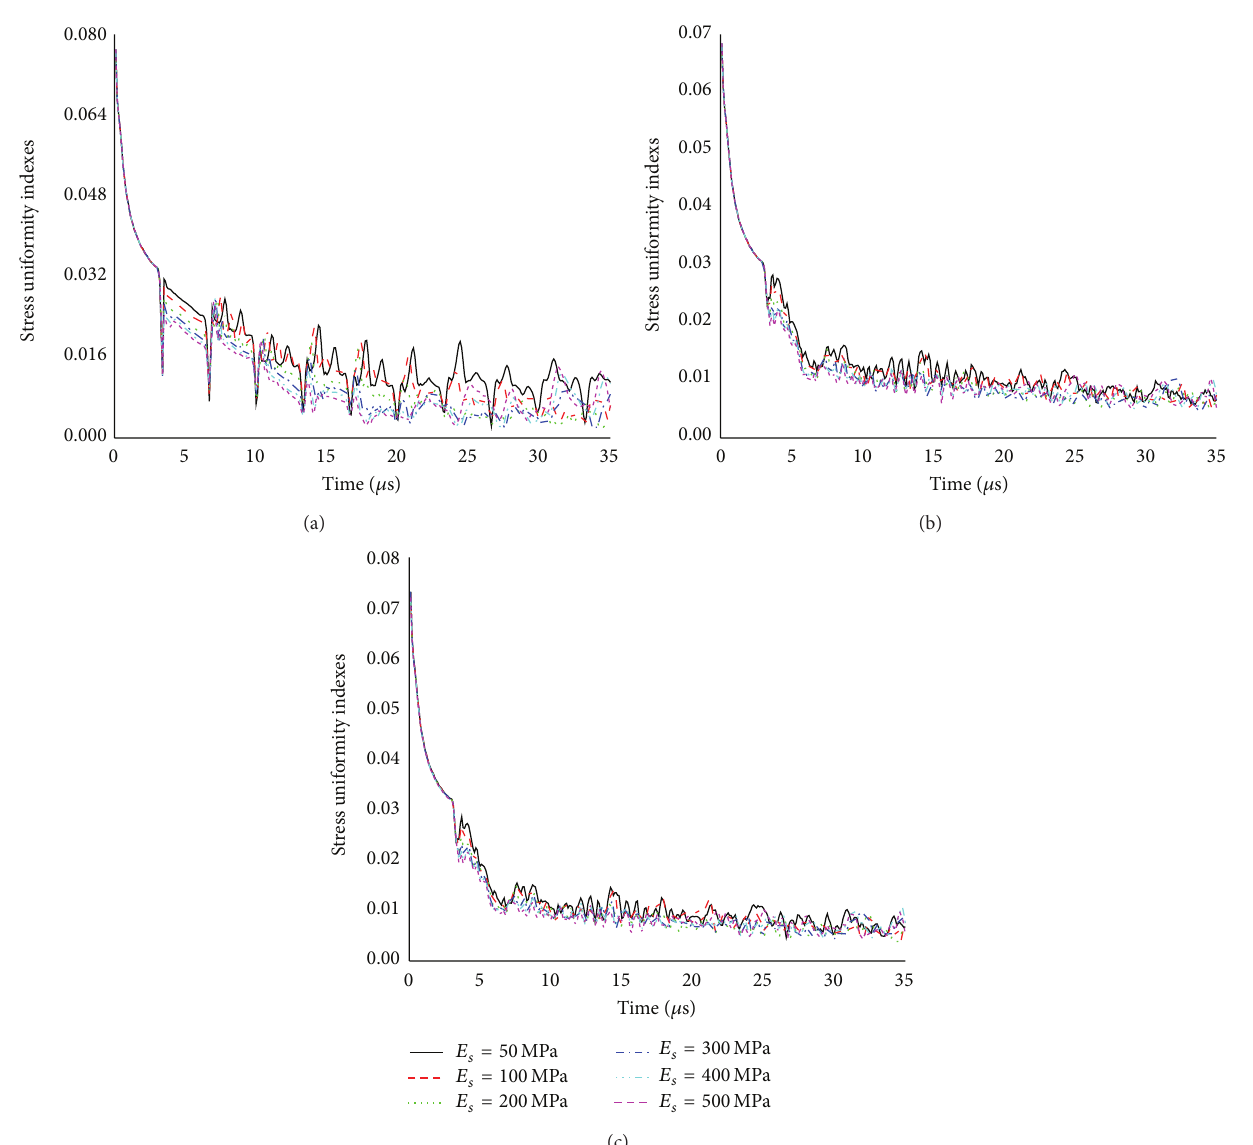
Figure 7: The influences of suture elastic modulus on the SUI of L-bone for three isotropic models: (a) model A, (b) model B, and (c) model